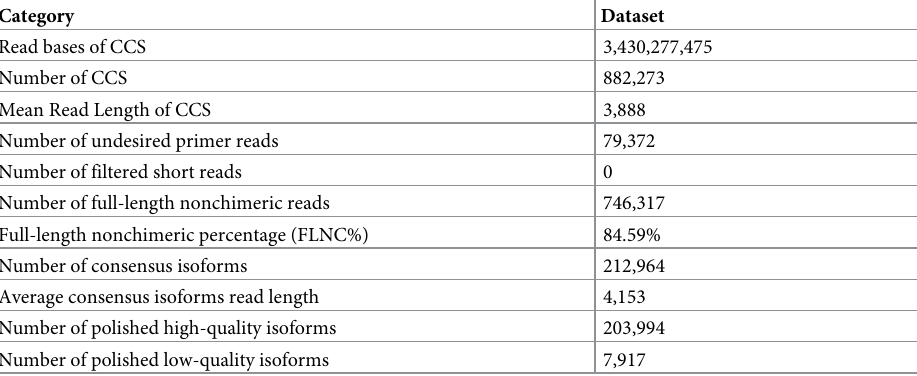
Table 2. Summary of PacBio SMRT sequencing of Gekko gecko .